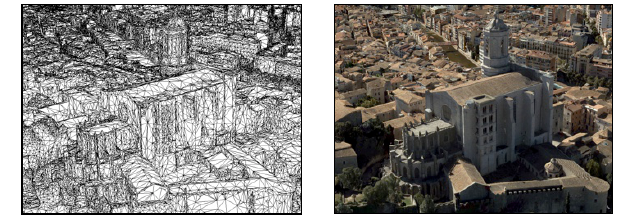
Figure 5 Hyperrealistic textured triangulation from the oblique